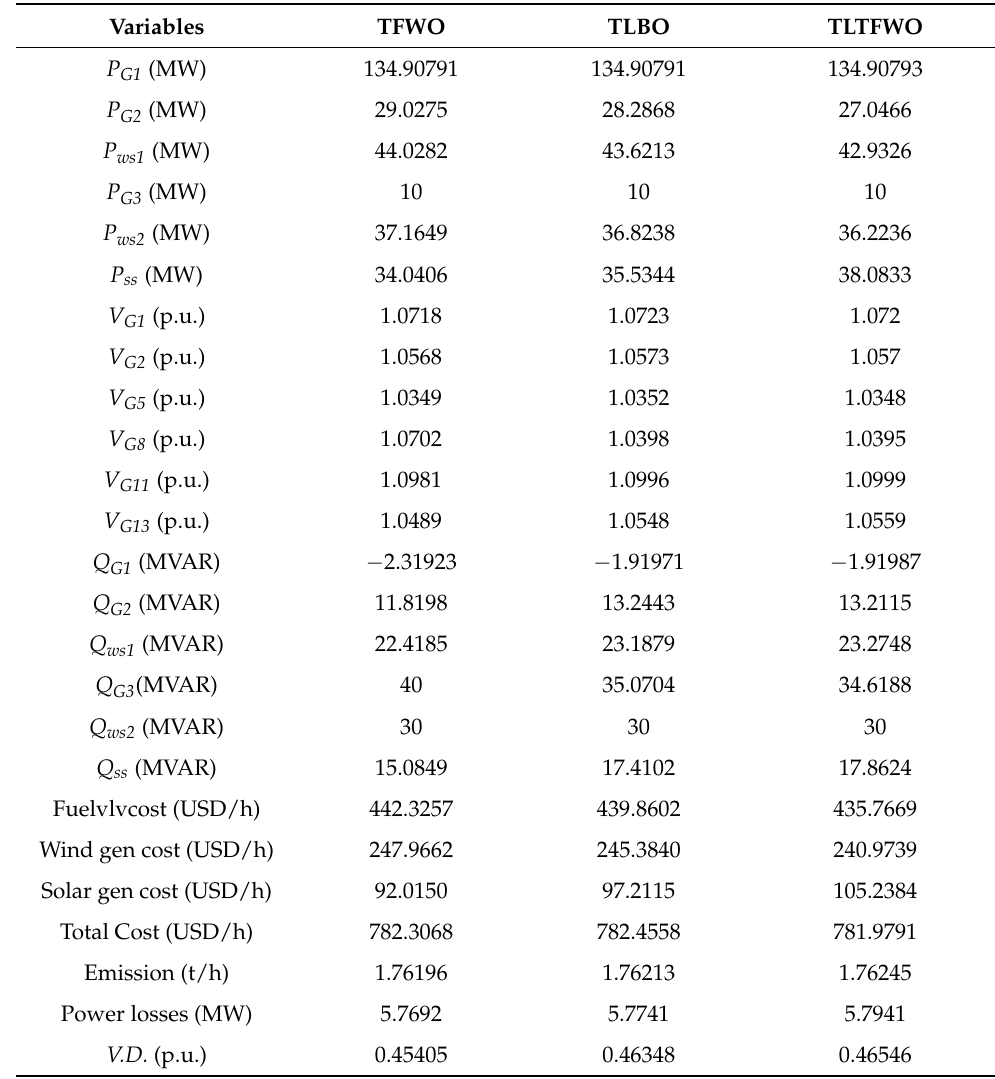
Table 11. Optimal variables in Case